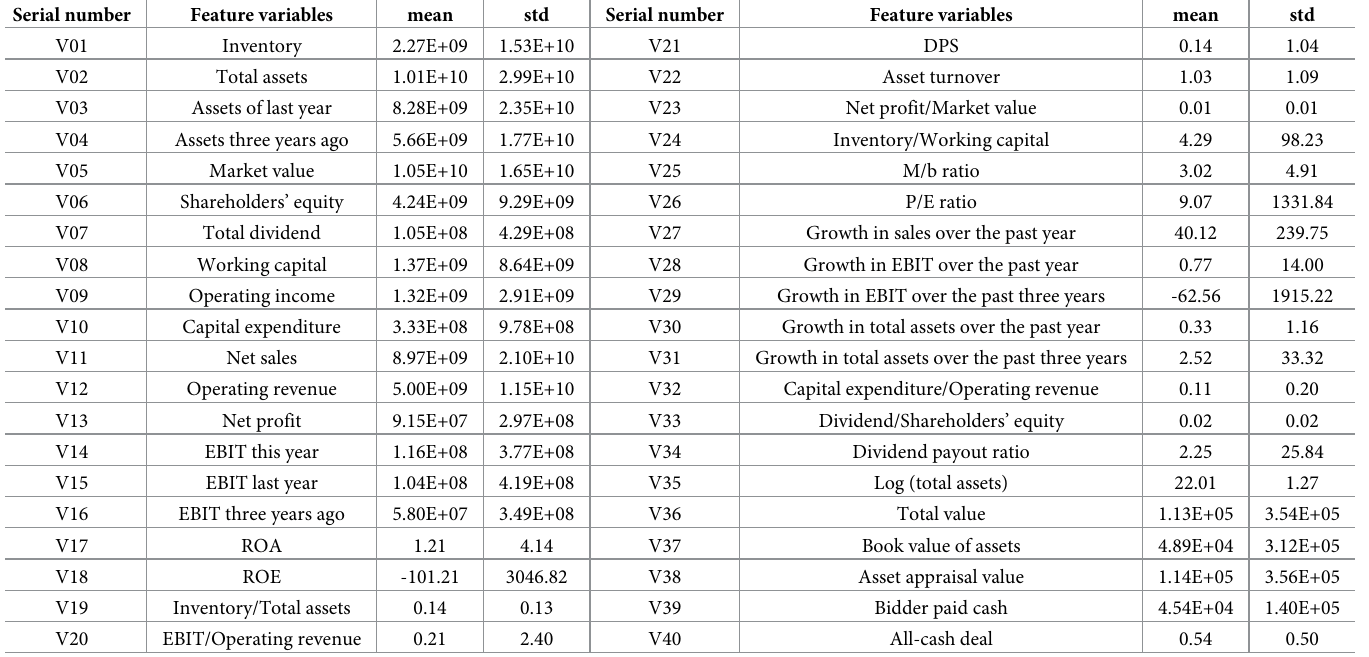
Table 2. Descriptive